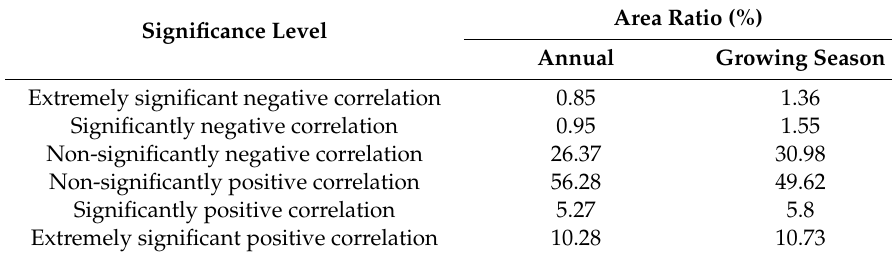
Table 7. Area ratios of NDVI and SPEI in di ff erent correlation